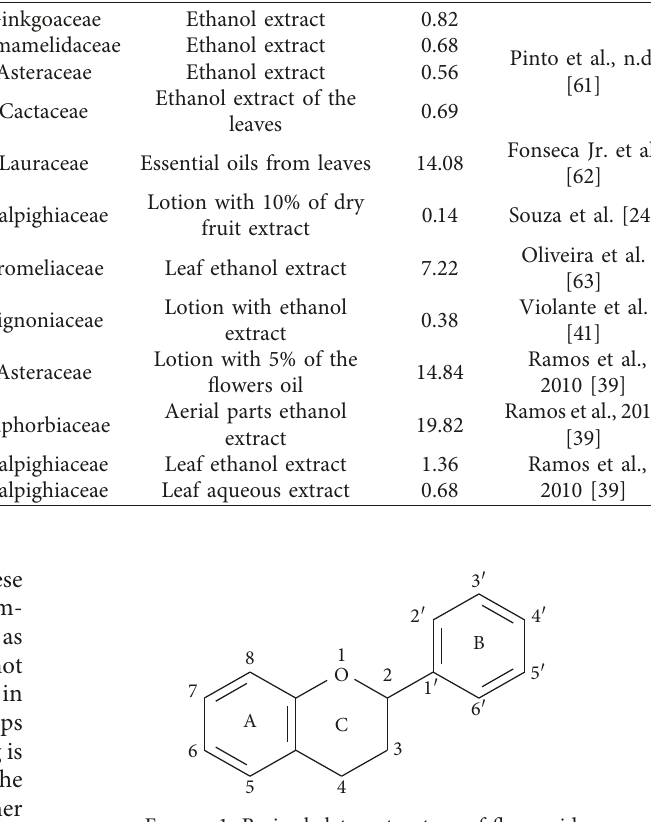
Figure 1: Basic skeleton structure of